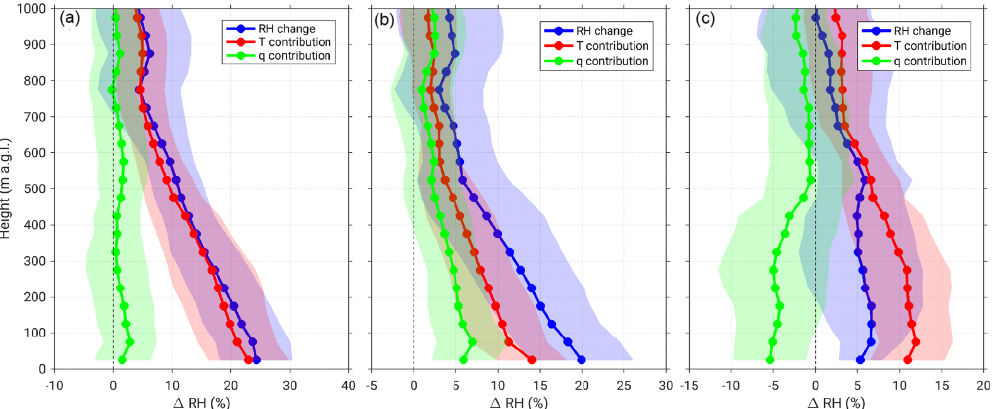
Figure 8. Mean profiles of relative humidity changes (RH change) and the contributions by temperature ( T contribution) and specific humidity ( q contribution) changes between 17:00UTC and the end of the jet phase (a) , between 17:00UTC and the beginning of the jet phase (P1, b) and between the beginning and end of the jet phase (P2, c ) averaged for all IOPs. For an overview of the considered time periods see Fig. 2. The shading indicates the standard deviation. Note that in (c) , IOPs 4 and 14 are not considered because not enough soundings exist for period